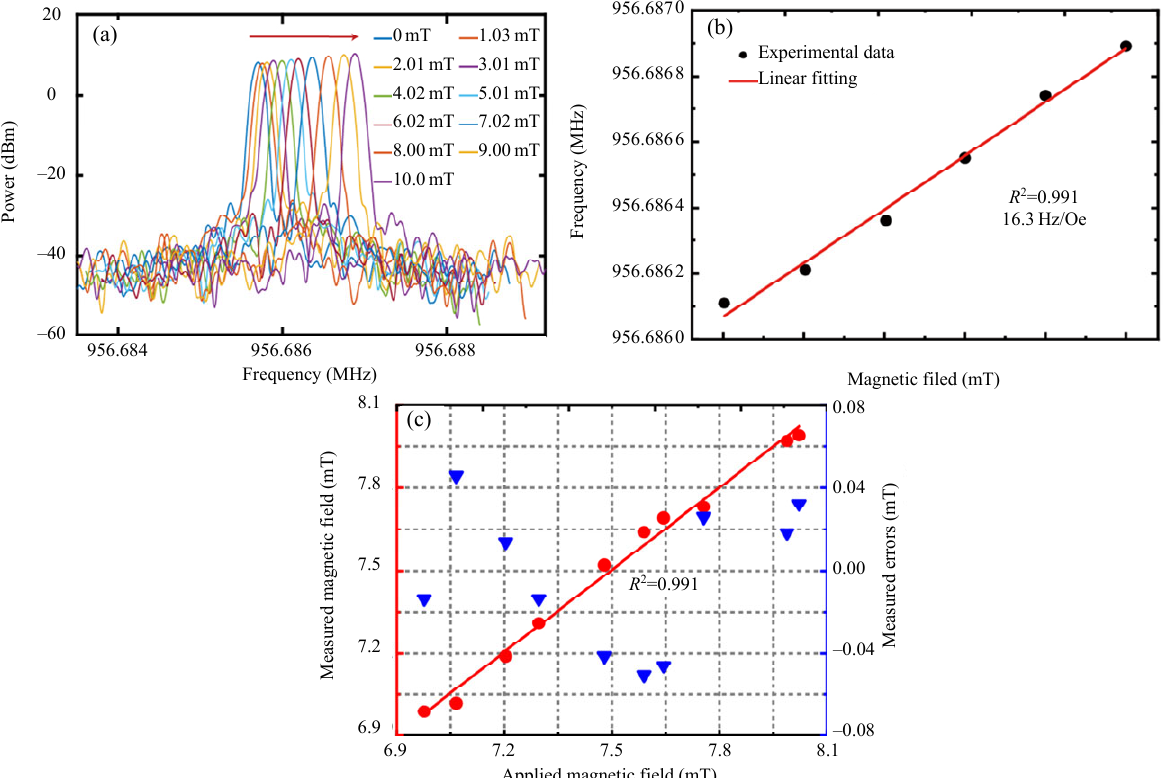
Fig. 5 Sensor performance characterization based on the etched FBG and the OEO: (a) the measured frequency responses under different magnetic fields, (b) relationship between the oscillating frequency shift and the magnetic field, and (c) the measured